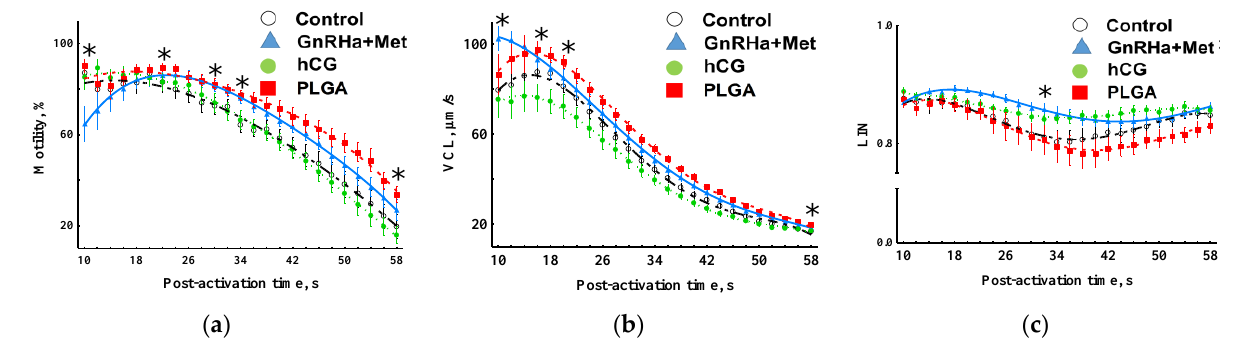
Figure 4. Dynamics of motility parameters during post-activation time for Bala shark spermatozoa obtained after hormonal treatments. ( a ) Sperm motility percentage (Motility); ( b ) curvilinear velocity (VCL); ( c ) sperm track linearity (LIN). Control (1 mL/kg 0.9% NaCl); hCG (20 µg/kg recombinant hCG); GnRHa + Met (25 μg/kg [ D-Ala 6 , Pro 9 , NEt]-GnRH with 20 mg/kg metoclopramide); PLGA (PLGA microparticles). Data are presented as means (dots) ± SE (whiskers), lines are quartic polynomial regression lines, * indicates a “point of interest” discussed in the text.